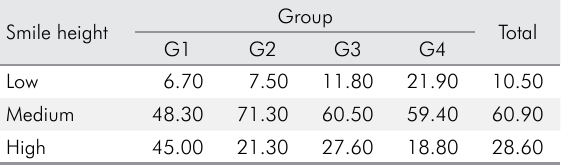
Table 5. Percentages of smile heights by group. p =0.010 (significant).